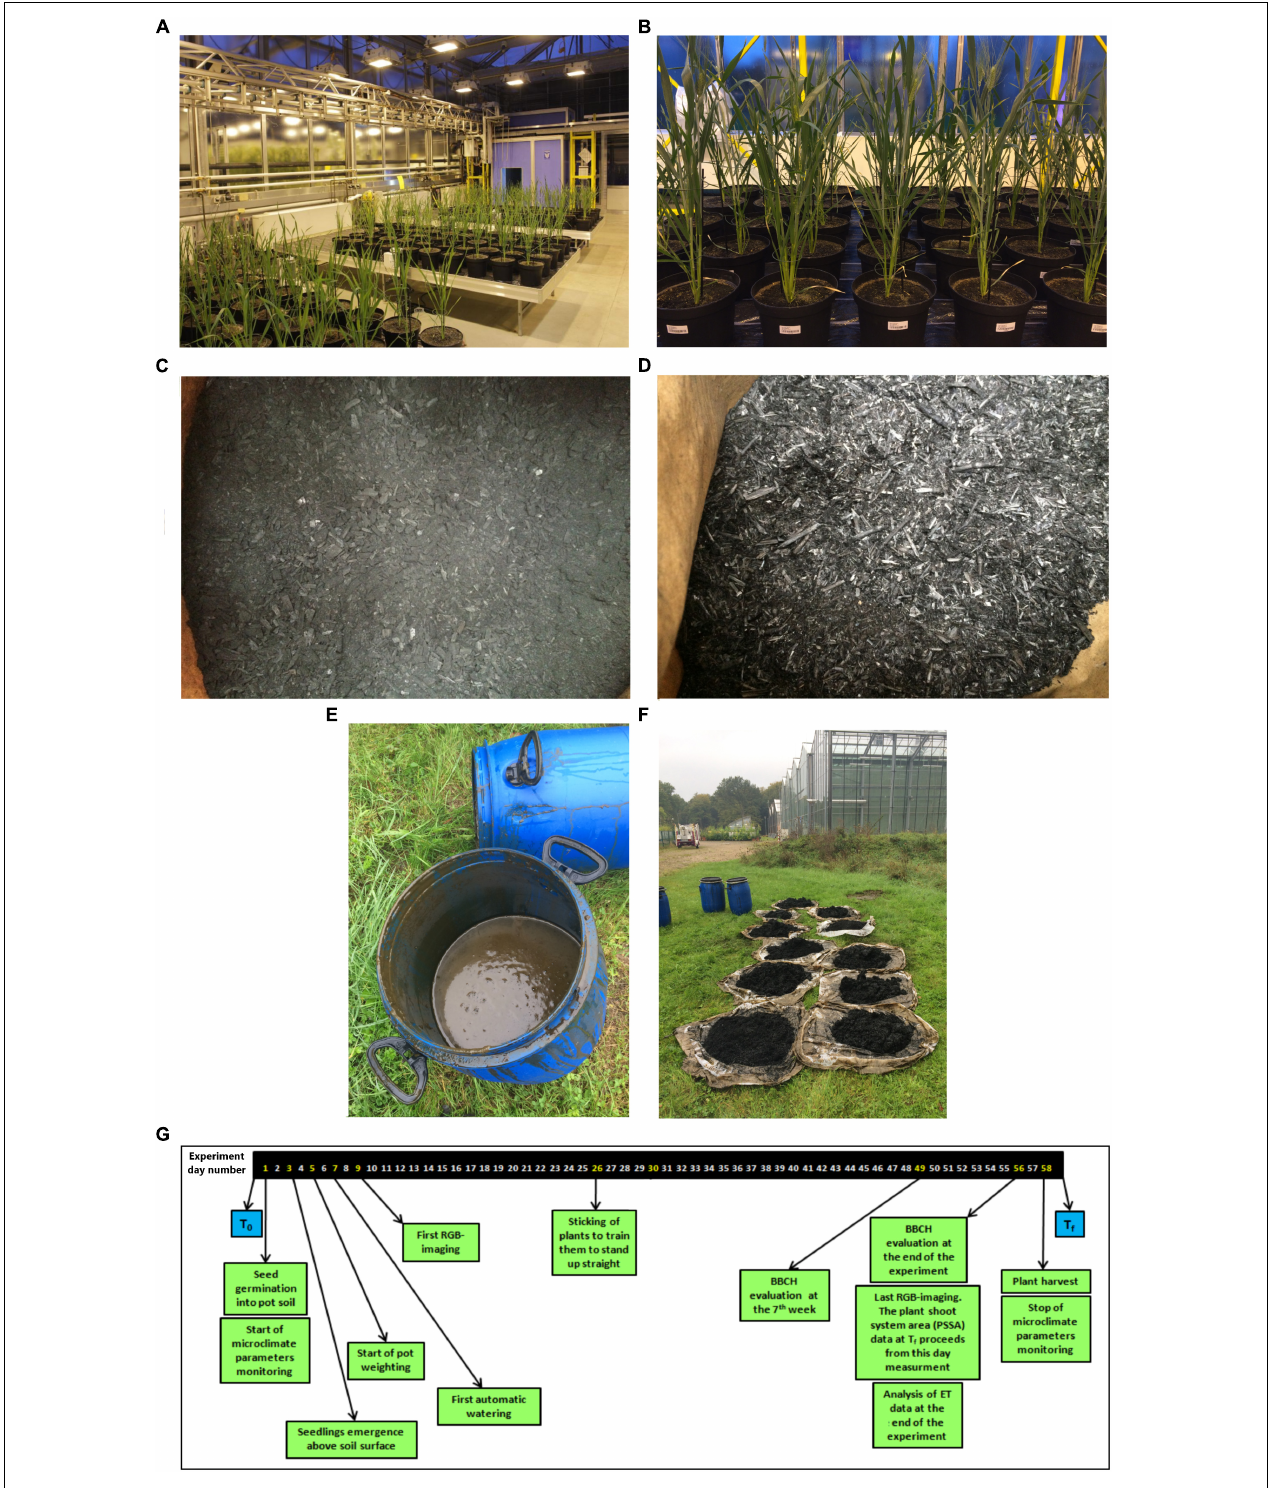
FIGURE 1 | (A) The 150 analyzed pot plants, positioned in three flood tray tables with 50 plants each, grown in the ScreenHouse on day 42; (B) plants on day 56 close to the end of the experiment, each pot being labeled with a code allowing for complete randomization; appearance of the biochar from (C) wood chips (B1) and (D) from wheat straw (B2), as provided by the producers; digestate solution contained in a 60-L bin where biochar [specifically for the treatments B1 and B2 incubated with digestate (B1D and B2D, respectively)] was previously dipped, wrapped in a tissue, for 10 days (E) ; (F) drying of the biochars after incubation in the digestate outdoor overnight; (G) timeline of the experiment conducted in the ScreenHouse. T 0 , beginning of the experiment; T f , end of the experiment; ET, evapotranspiration.